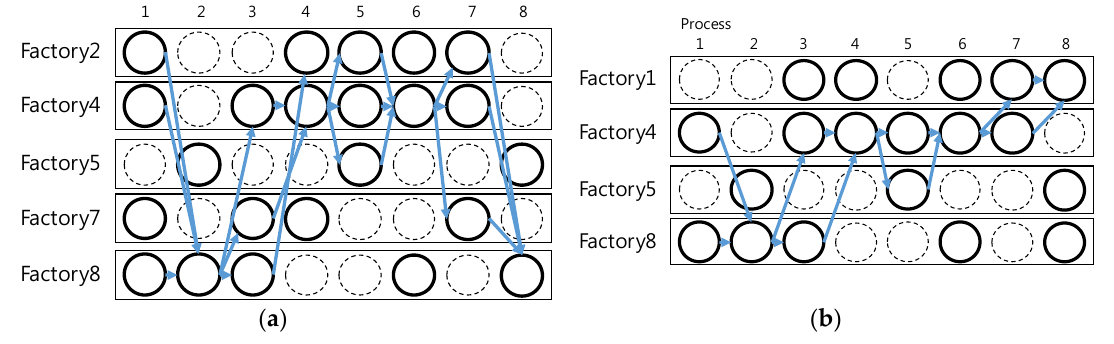
Figure 6. Dynamic supply chain design. ( a ) 20% less capacity; ( b ) 30% more capacity.